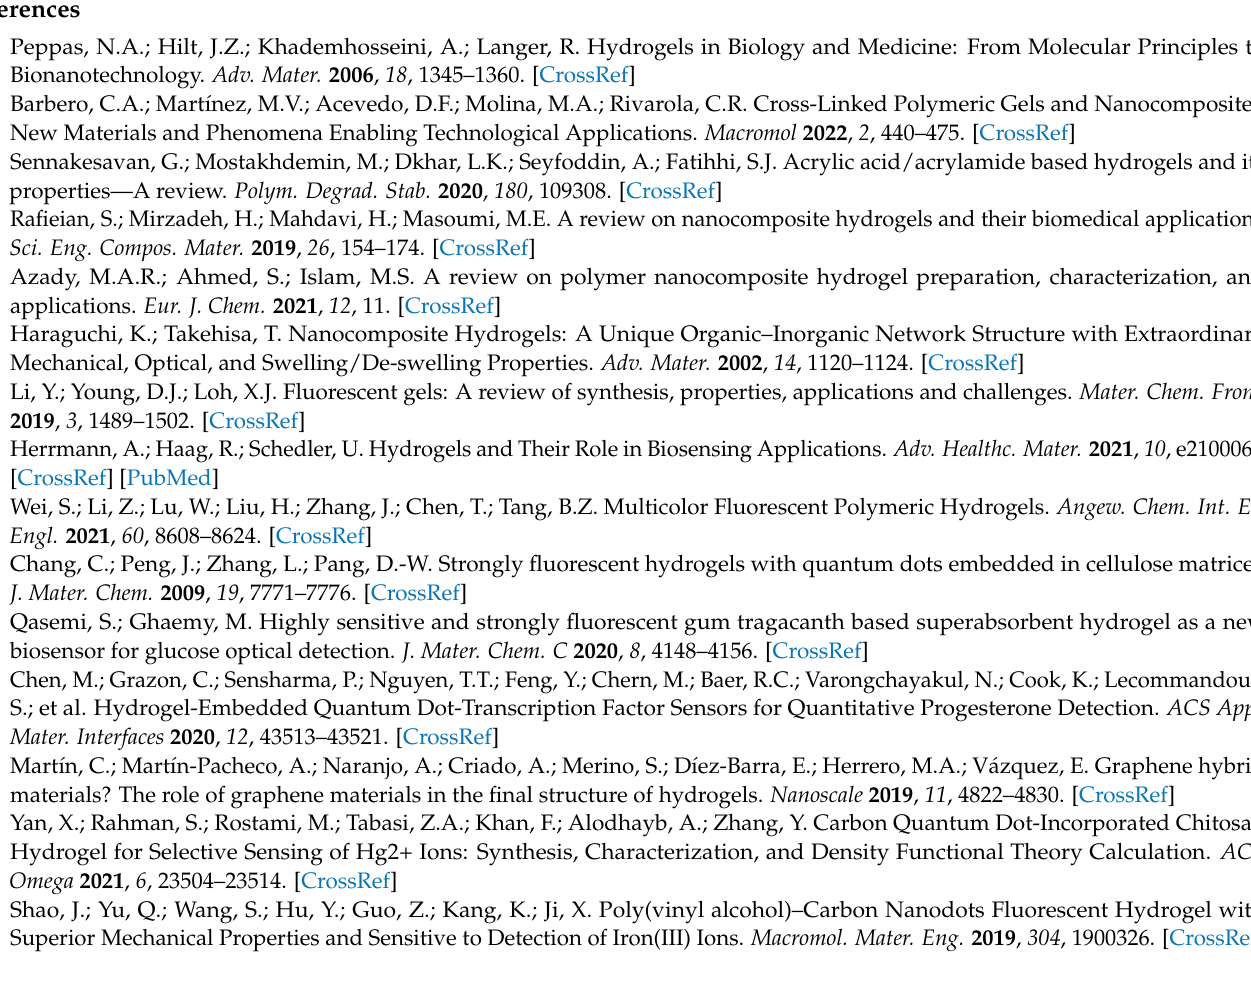
Figure S3: Effect of increasing concentrations of CNPs; Figure S4: Digital image of F8BT@AETA. Figure S5: Fluorescence quenching kinetics of PFO@AETA with